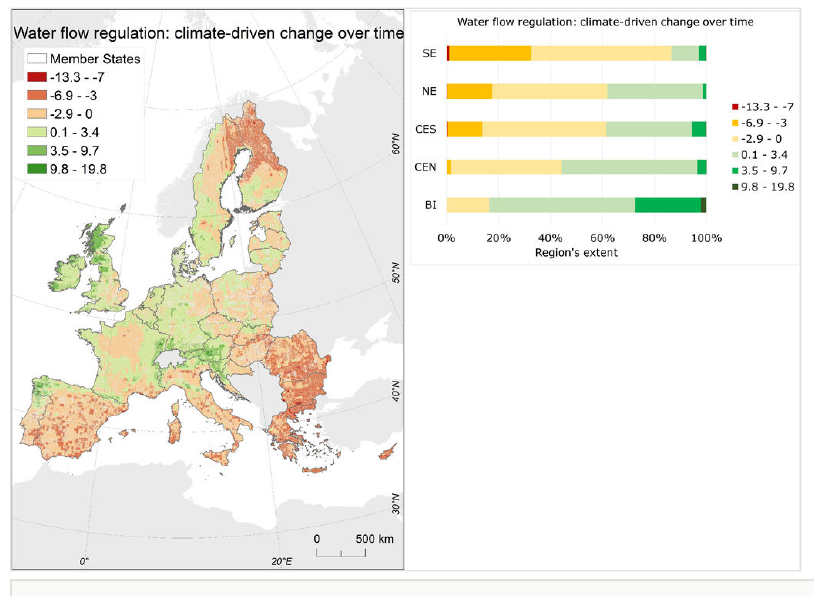
Figure 14. Change in water fl ow regulation over time (2050 vs. baseline), in areas where LULC was predicted to remain the same. Areas mapped in dark red indicate largest percent decrease, areas mapped in dark green indicate the largest percent increase. The bar chart shows the change as a relative extent percent, for fi ve European regions de fi ned after grouping the 28 Member States according to their climatic characteristics (Ciscar Martinez et al. 2011). The map is displayed using the Projected Reference System